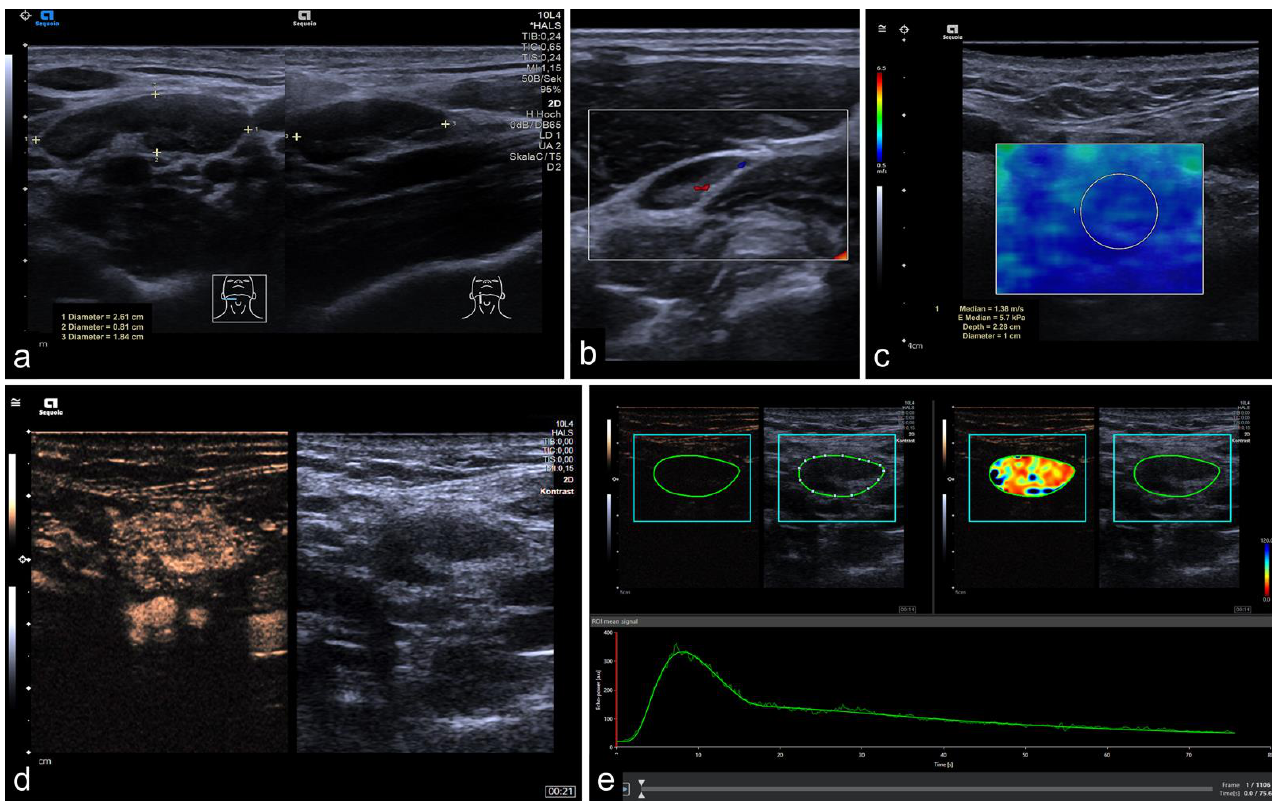
Figure 1. Representative image of mpUS workflow. ( a ) Long-axis and short-axis diameter measured in dual mode, ( b ) color-coded Doppler US depicting macrovascularity, ( c ) SWE measured by circular ROI revealed low tissue stiffness (1.38 m/s), ( d ) CEUS image 21 s after contrast injection with regular enhancement, and ( e ) RAW data perfusion analysis with demarcation margins (blue) and lesion ROI (green) showing the corresponding time-intensity curve and color-coded map. The CLN was confirmed as benign.